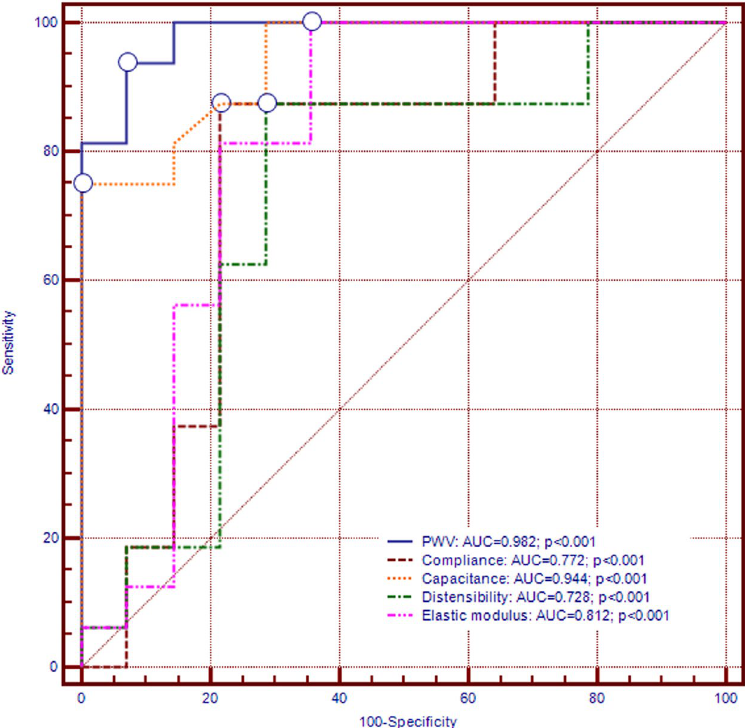
Figure 2. Receiver operator characteristic curve highlighting the diagnostic ability of pulmonary artery stiffness indices for identifying pulmonary hypertension.